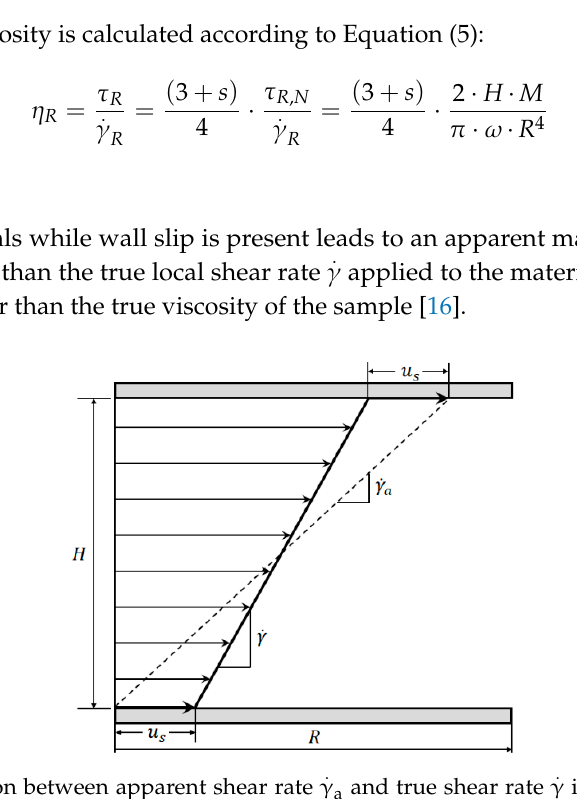
Figure 2. Comparison between apparent shear rate γ(cid:4662) (cid:2911) and true shear rate γ(cid:4662) in the velocity profile between two parallel plates showing wall slip.